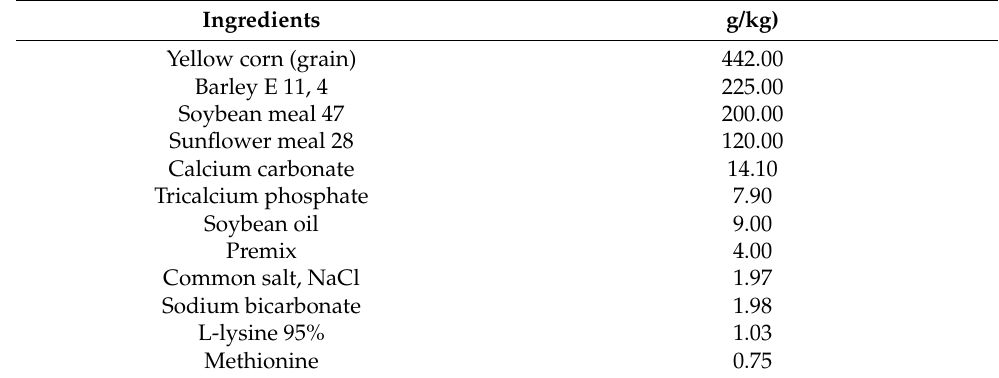
Table 2. Ingredient composition of the commercial